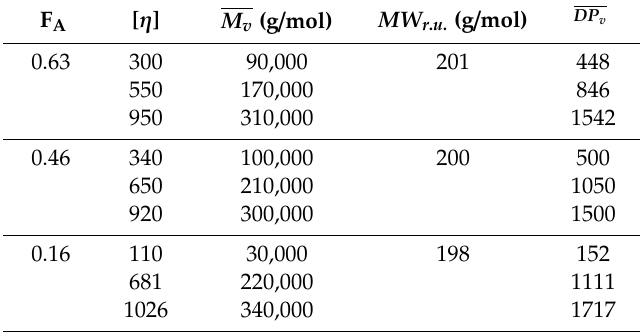
Table 1. The fraction of acetylated units (F A ), intrinsic viscosity, [ η ], viscosity average molar mass, M v , molar mass of chitosan repetitive unit, MW r . u . , and viscosity average degree of polymerization, DP v , of hydrochloride chitosans used for the synthesis of coacervates. M v is calculated using the following Mark–Houwink–Sakurada parameters, i.e., K = 8.43 × 10 − 3 mL / g and a = 0.92 according to Berth and Dautzenberg [28]. The F A was determined by means of 1 H-NMR [29], whereas [ η ] was